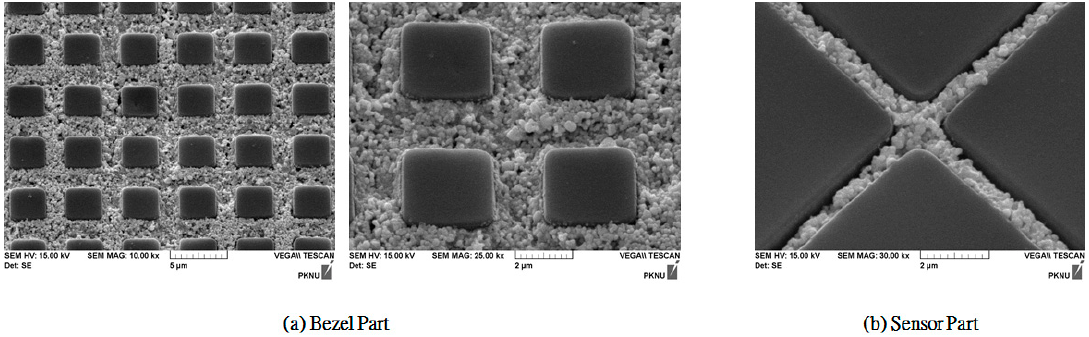
Figure 6. SEM images of filled Ag/Cu@Ag mixture paste in ( a ) bezel and ( b ) sensor parts of metal meshes touch screen panel.